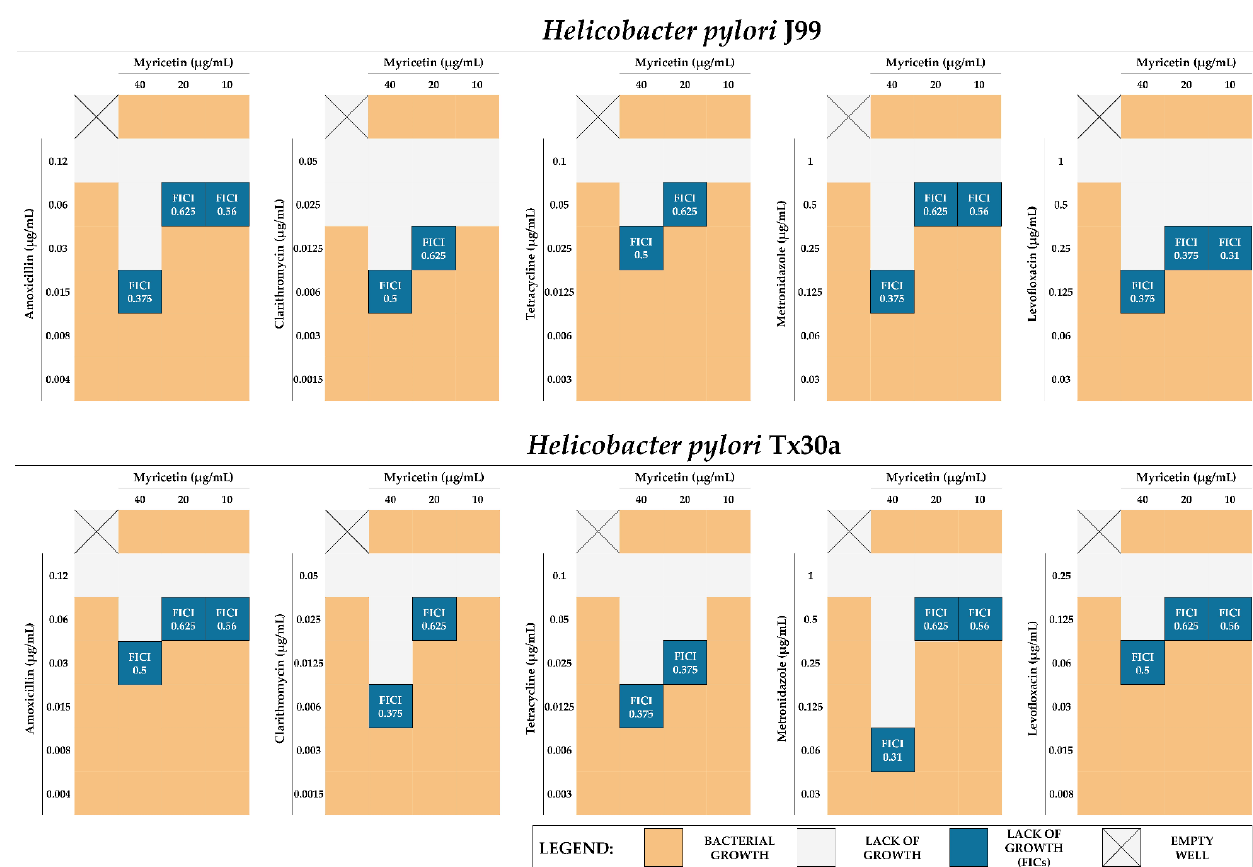
Figure 5. Graphical representation of the results of checkerboard assays testing synergistic interactions between myricetin and antibiotics against reference H. pylori J99 and Tx30a strains. The MIC of myricetin for both strains is equal to 160 µg/mL. The MICs for amoxicillin, tetracycline, and metronidazole for both strains count for 0.12, 0.1, and 1 µg/mL, respectively. The MICs for clarithromycin and levofloxacin are equal to 0.025 and 1 µg/mL for H. pylori J99, and 0.05 and 0.25 µg/mL for H. pylori Tx30a. The blue field marks the wells of the titration plates, in which no bacterial growth and a positive interaction between the tested compounds was observed. The interactions were interpreted based on the calculation of the fractional inhibitory concentration index (FICI), in which ≤0.5 and >0.5 but ≤1 was considered as synergism and additivity, respectively.